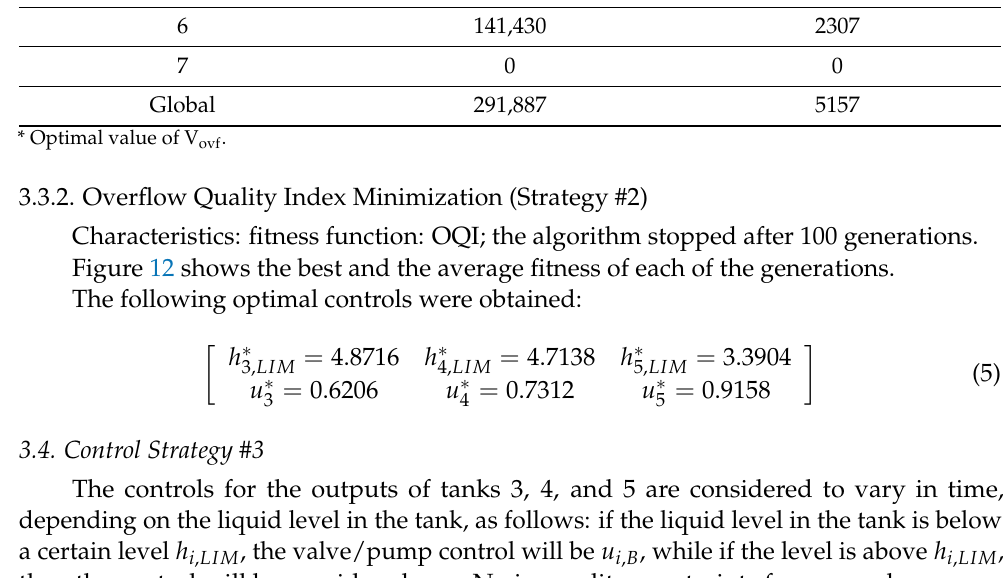
Table 9. Simulation results when the volume of overflow is minimized (strategy #2).